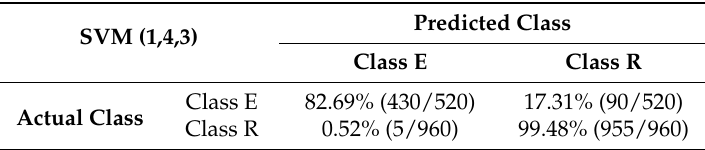
Table 8. Confusion matrices for